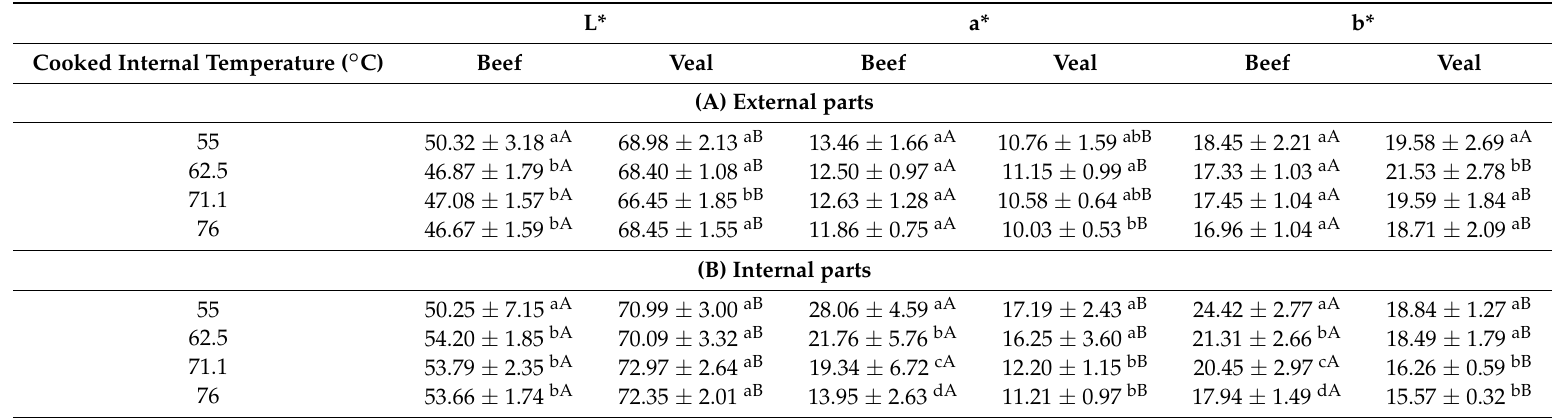
Table 4. Color values (L*, a*, and b*) of the external (A) and internal (B) parts of course ground beef and veal patties double pan-broiling to internal end-point temperatures of 55, 62.5, 71.1, and 76 ◦